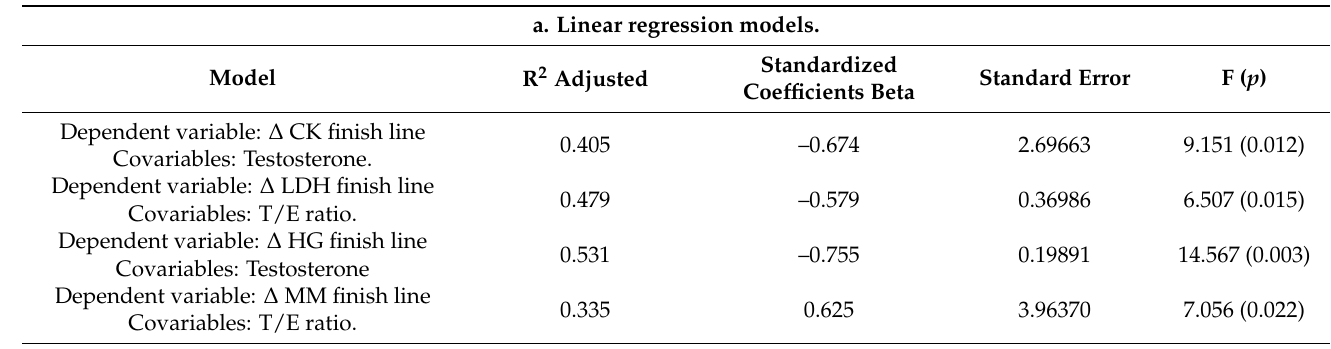
Table 4. Multivariate